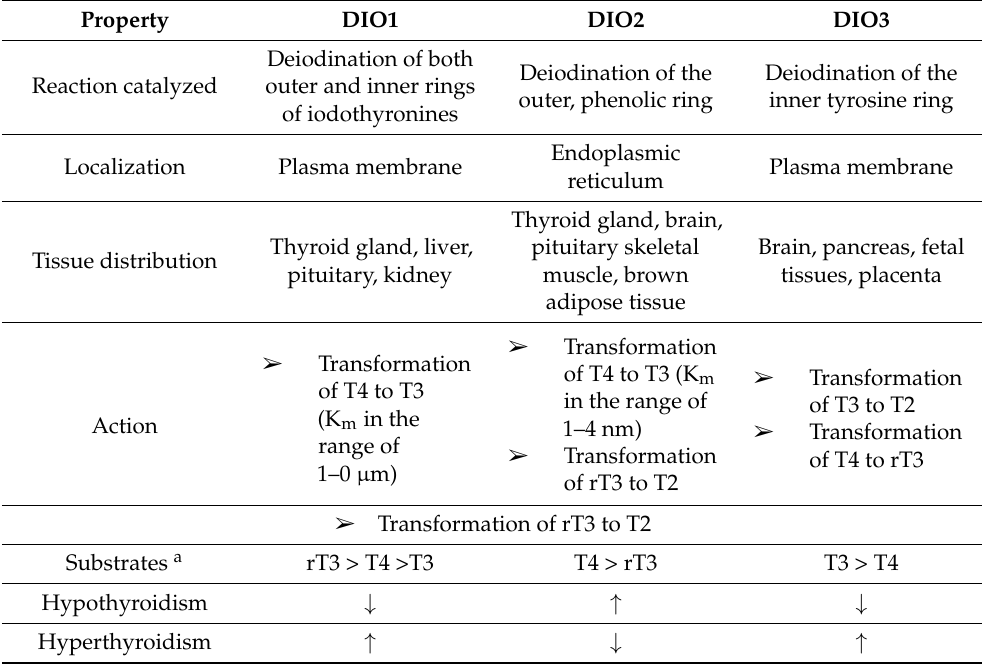
Table 1. The main properties of distinct